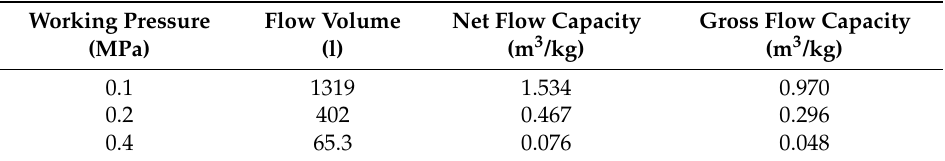
Table 1. Experimental flow volumes and flow capacities achieved with the same compressor and battery setup at different working pressures, based on [23].